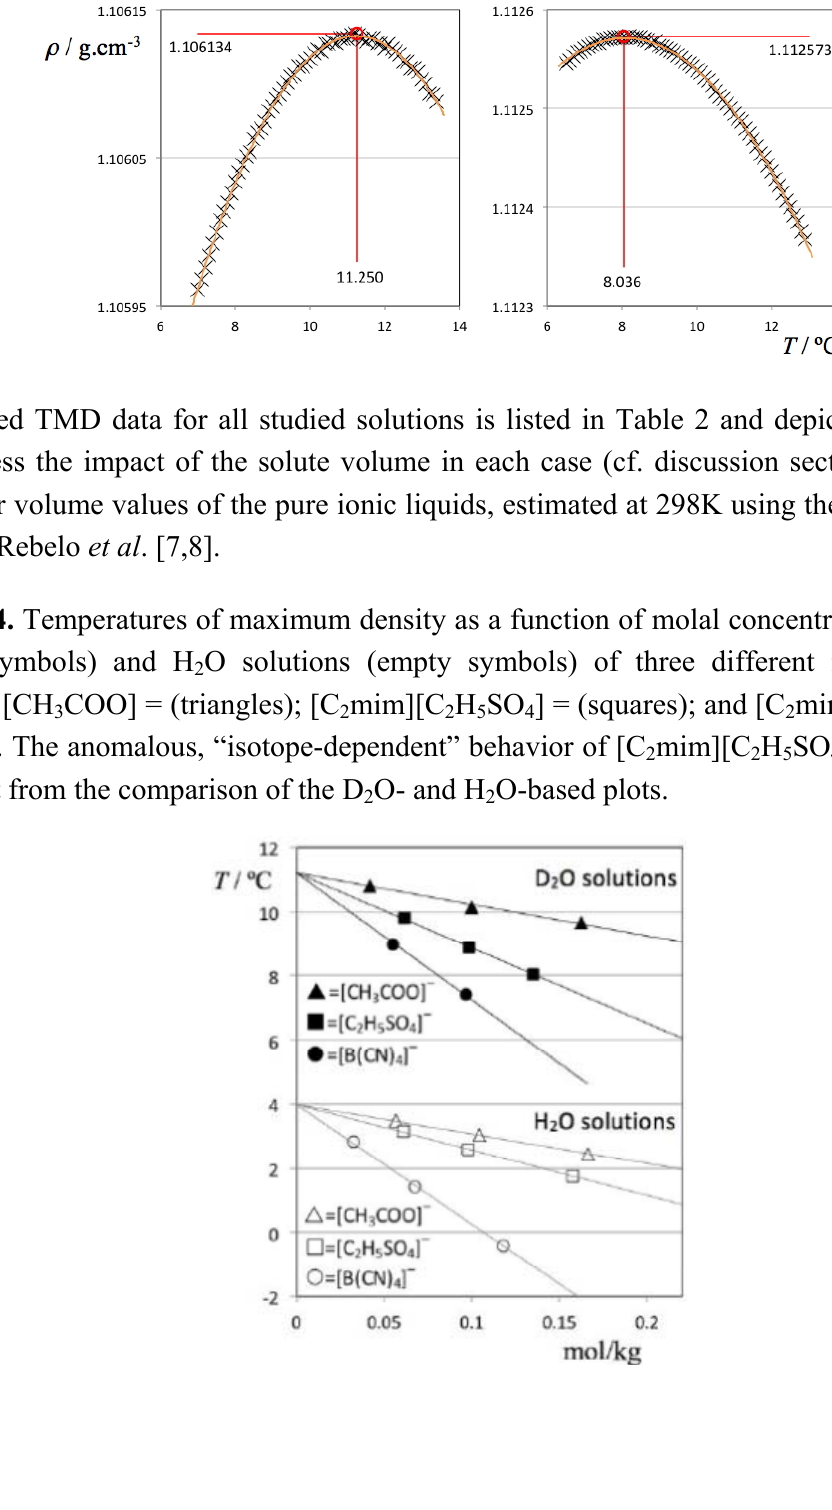
Figure 3. Density as a function of temperature for pure deuterated water (left panel) and a